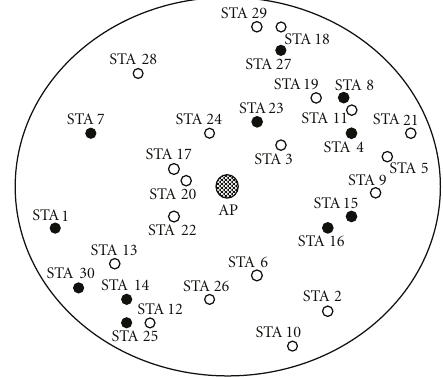
Figure 3: IEEE 802.11a wireless LAN.